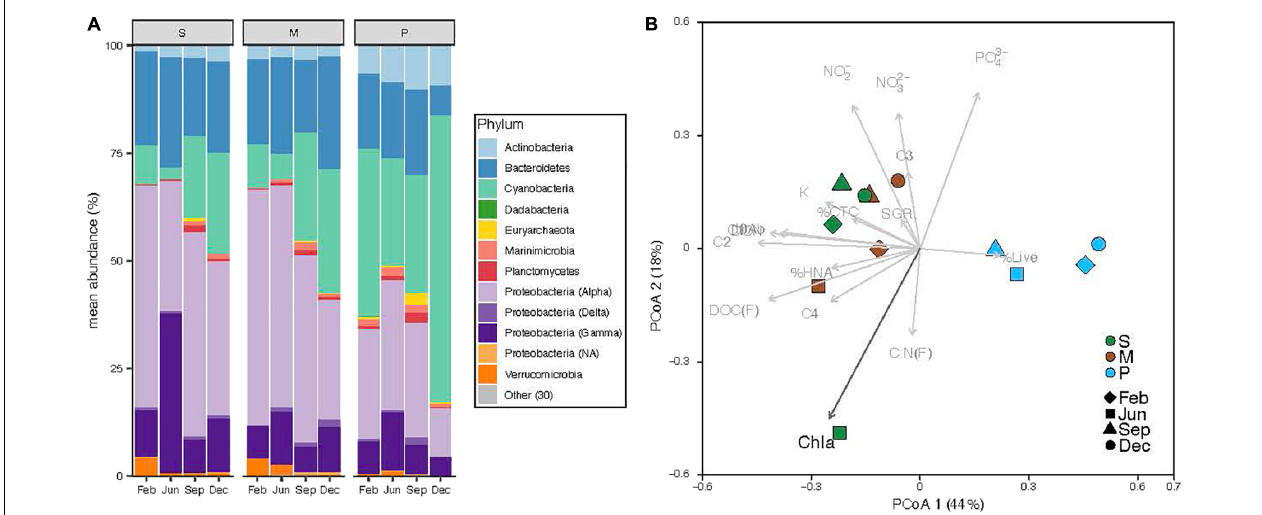
FIGURE 7 | Prokaryotic diversity at the time of sample collection at the three sites (S, Seagrass; M, Mangrove; P, Phytoplankton), showing the relative abundance of sequences belonging to the top 10 most abundant phyla, with Proteobacteria further divided into its major classes (A) and distribution of samples according to Principal Coordinates Analysis of Bray–Curtis distances with biological and environmental variables overlaid (B) . Black arrows show significant effects ( p >